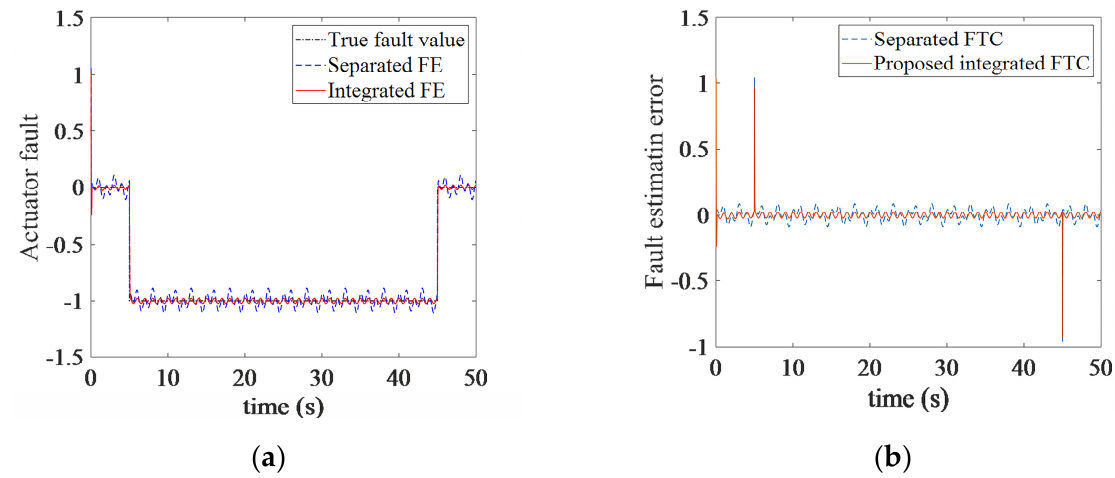
Figure 6. ( a ) True and estimated fault values in fault case 1; ( b ) fault case 1 fault estimation error.